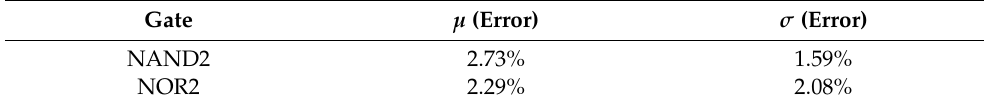
Table 13. Average errors of NAND2 and NOR2 gates.